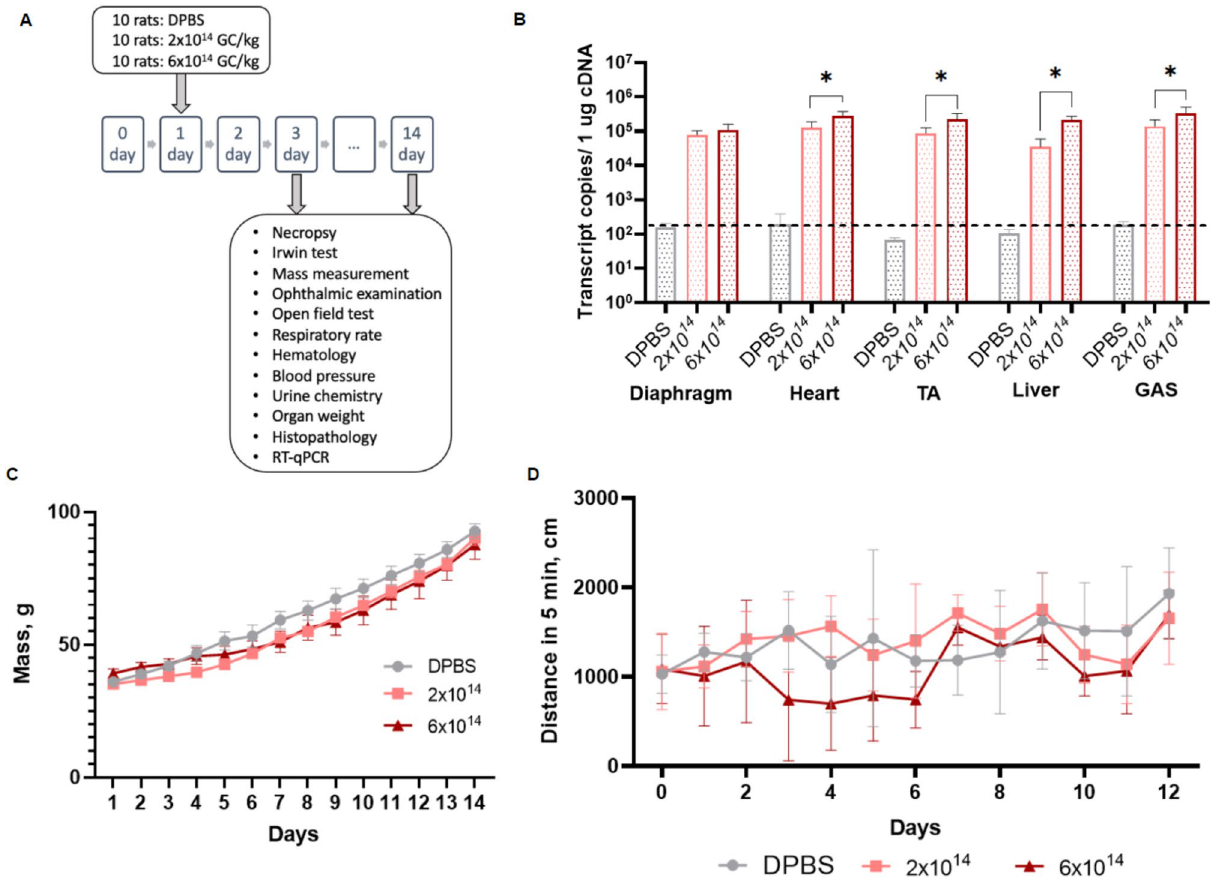
Figure 5. Systemic administration of rAAV9-Hco-µUtrn-FLAG at doses 2 × 10 12 and 6 × 10 12 vg kg −1 does not cause toxicity in rats after 3 and 14 days post injection. ( A ) Study design. ( B ) Transgene expression levels in the diaphragm, heart, tibialis anterior (TA), liver, and gastrocnemius (GAS) of rats, as determined via RT-qPCR. Values are expressed as transcript copies per 1 µg cDNA. The dashed line represents the detection levels of negative controls. ( C ) Body weight changes in experimental and control animals. ( D ) Distance traveled in 5 min during the open field test. All values are presented as the mean ± SEM (n = 5/time point). Statistical significance was set at P ≤ 0.05.